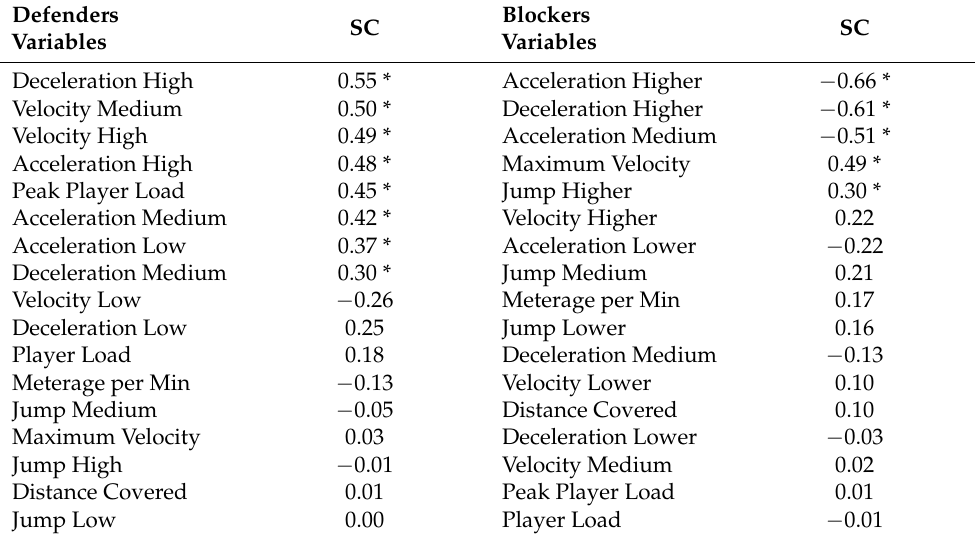
Table 4. Discriminant function structure coefficients and tests of statistical significance of GPS variables that impact match outcome (victory and defeat) according to player position (Defender vs. Blocker) in female beach